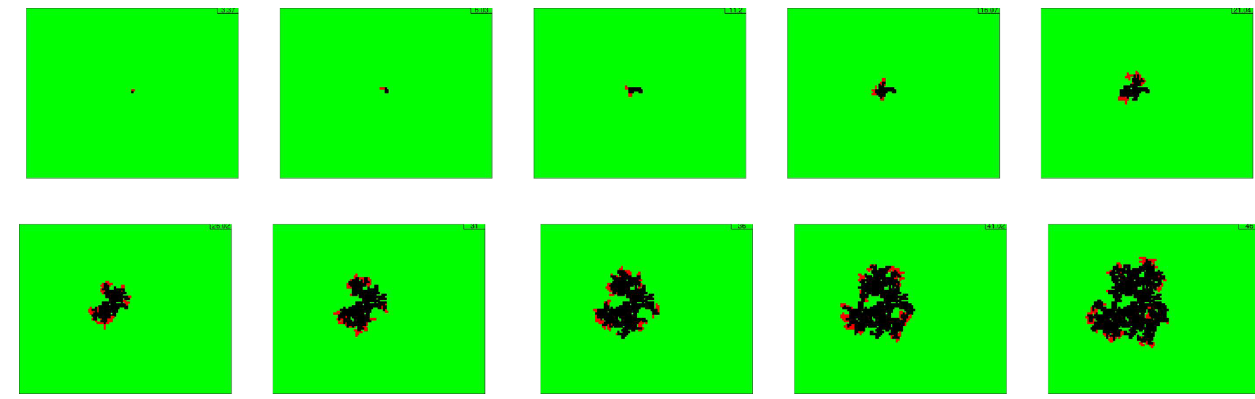
parameter estimates and the amount of scaling performed to increase the pixel